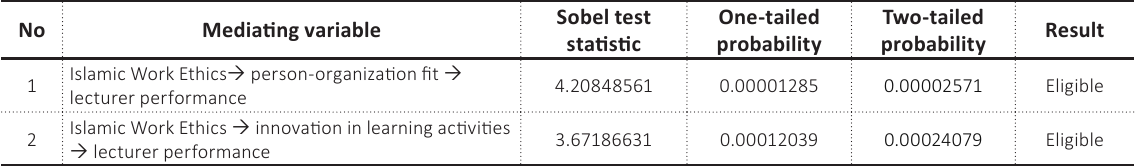
Table 6. Mediating person-organization fit and innovation in learning